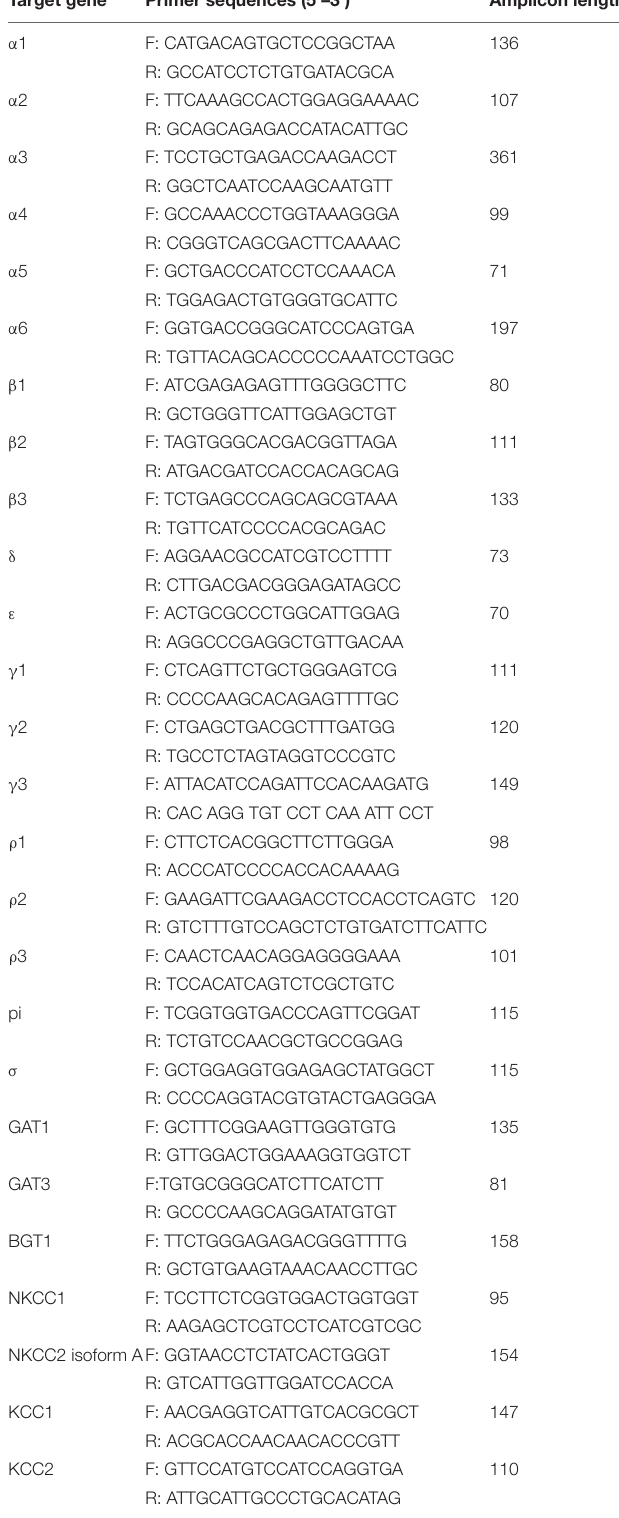
TABLE 1 | Primer sequences for GABA receptor subunits and transporters as determined by qPCR. Target gene Primer sequences (5 (cid:48) –3 (cid:48)